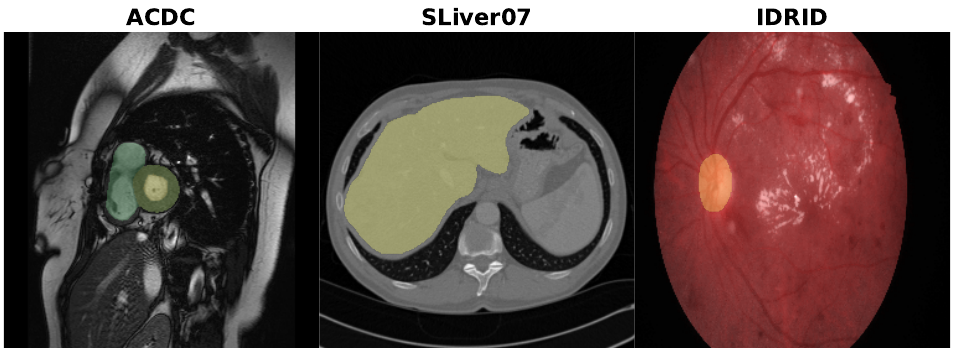
Figure 3. Examples of images and the segmented structures for ACDC, SLiver07, and IDRiD